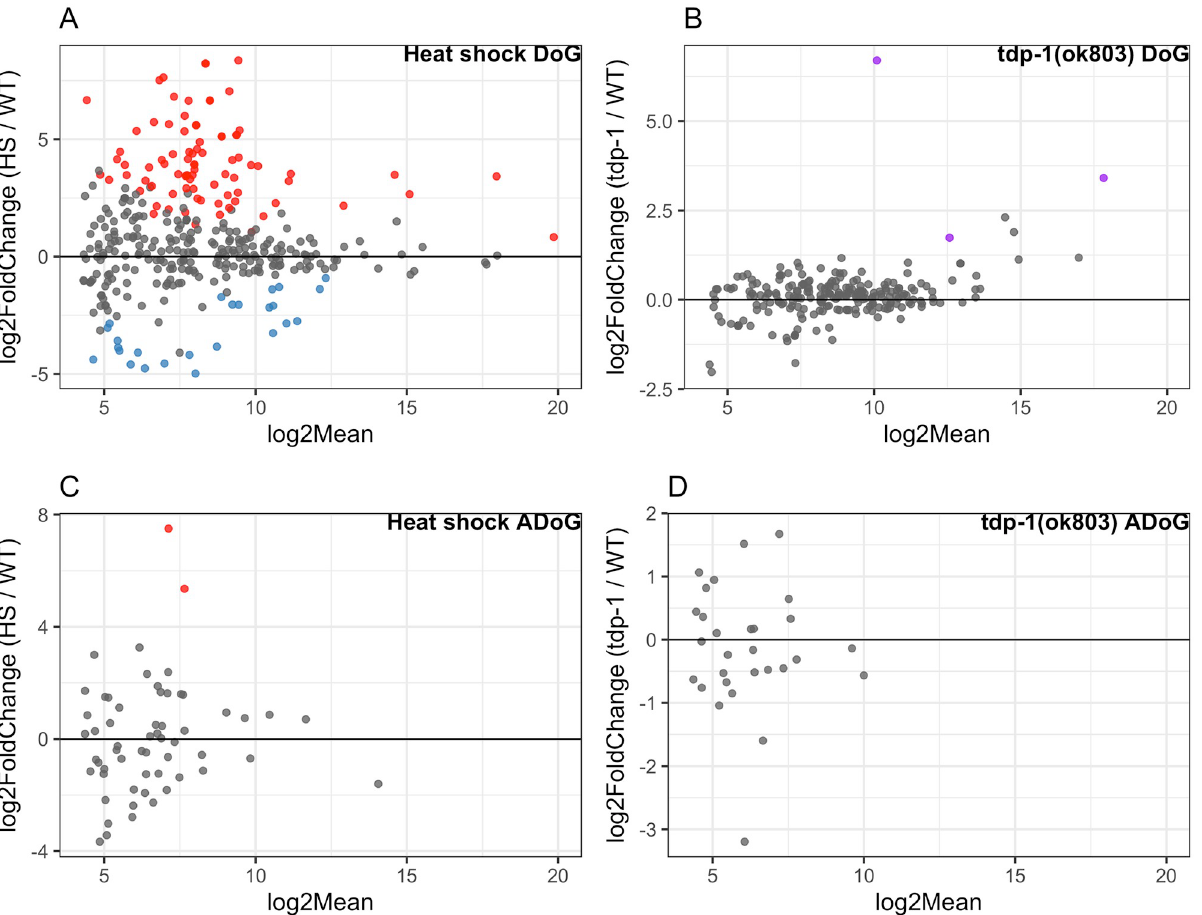
Fig 5. J2 enrichment of DoGs and ADoGs in heat shock and tdp-1(ok803) worms. MA plots of significant (FDR < 0.05) dsRNA enrichment for DoGs and ADoGs. Annotated genes that were not significantly changing were added in with DoGs or ADoGs for DESeq2 normalization but were taken out of the plots for clarity [n = 2 for heat shock J2 samples, n = 3 for wild type, n = 3 for tdp-1(ok803) ]. (A) Heat shock over wild type J2 enriched read through sense transcripts with 84 enriched (red) and 25 depleted (blue) out of 421 scored DoGs. (B) tdp-1(ok803) over wild type significant J2 enriched read through sense transcripts with 3 enriched (purple) out of 265 scored DoGs. (C) Heat shock over wild type J2 enriched read through antisense transcripts with 2 enriched (red) out of 70 scored ADoGs. (D) No significant tdp-1(ok803) over wild type J2 enriched read through antisense transcripts out of 43 scored